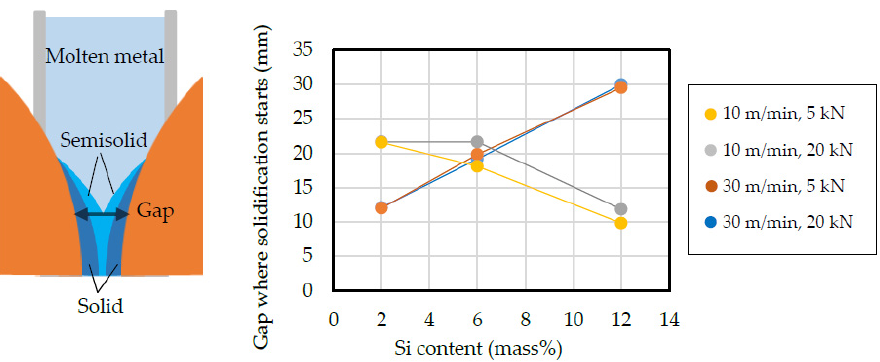
Figure 10. Gap where solidification started, as calculated from solidification starting positions and strip thicknesses. Roll speed: 10 m/min and 30 m/min; roll load: 5 kN and 20 kN; Si content: 2%, 6%, and 12%.